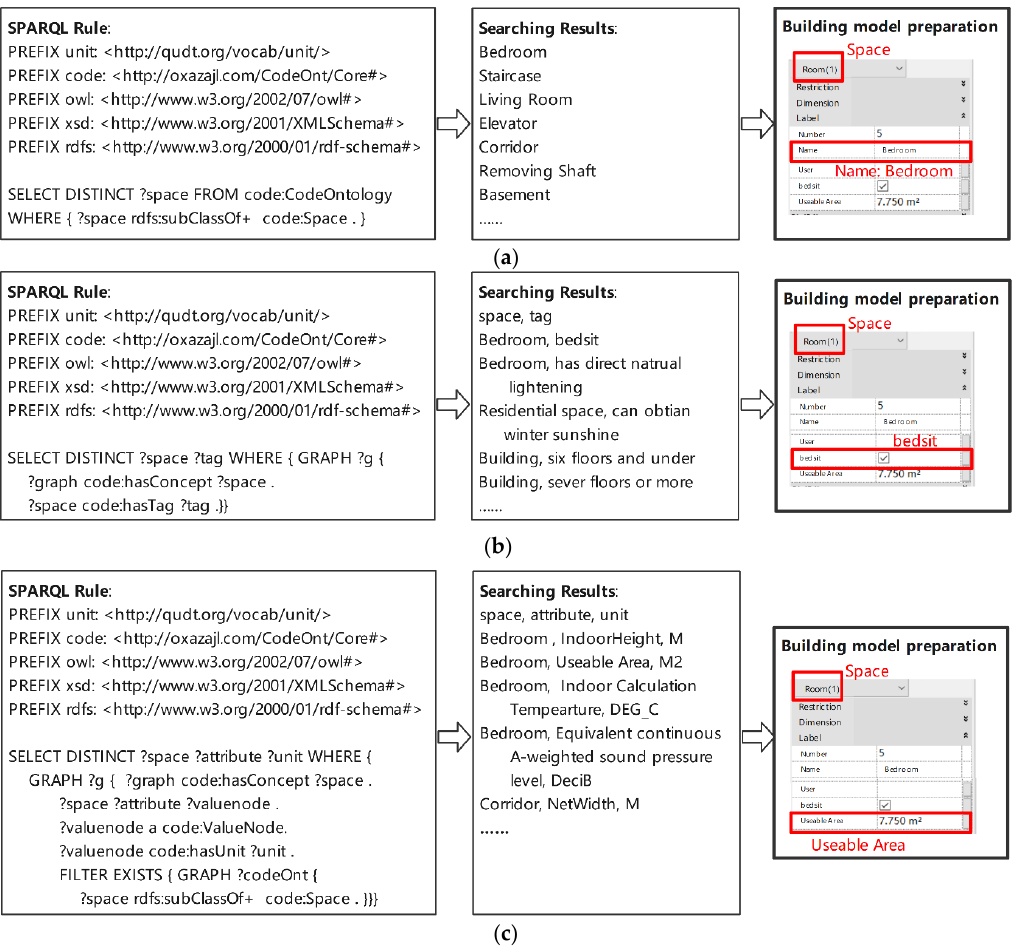
Figure 21. SPARQL queries to retrieve information requirements for building model preparation: ( a ) SPARQL query to retrieve terminologies of space types; ( b ) SPARQL query to retrieve related tags of spaces; ( c ) SPARQL query to retrieve corresponding attributes of spaces.